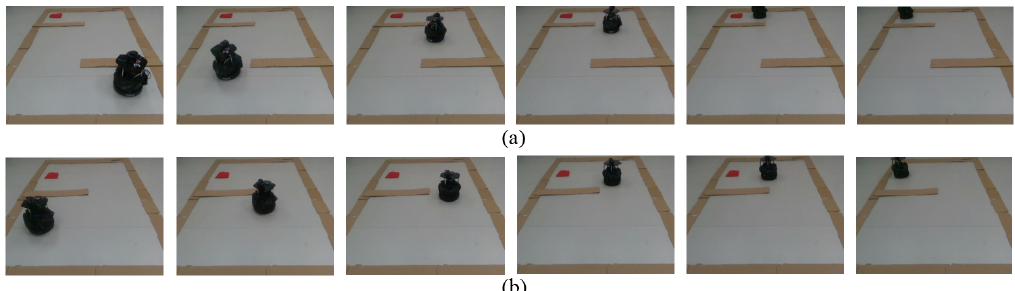
Figure 11. Frames of the final policies trained with our method employed on the navigation task in real-world working scenarios. The TurtleBot navigates to the target position without obstacle collision. ( a ) two obstacles. ( b ) one